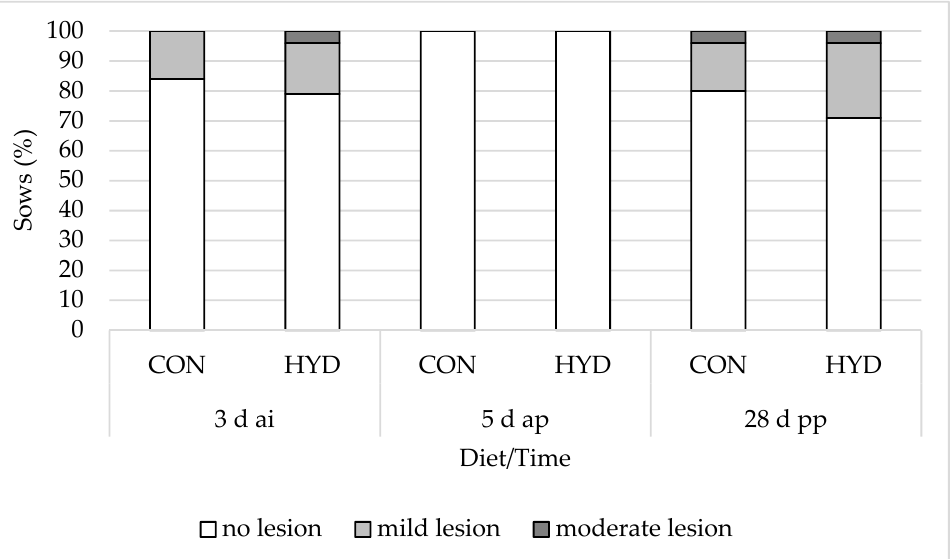
Figure 2. Effect of dietary vitamin D source on prevalence (%) of shoulder lesions of sows. CON, 50 μ g/kg vitamin D 3 ( n = 25); HYD, 50 μ g/kg 25-OHD 3 ( n = 24).